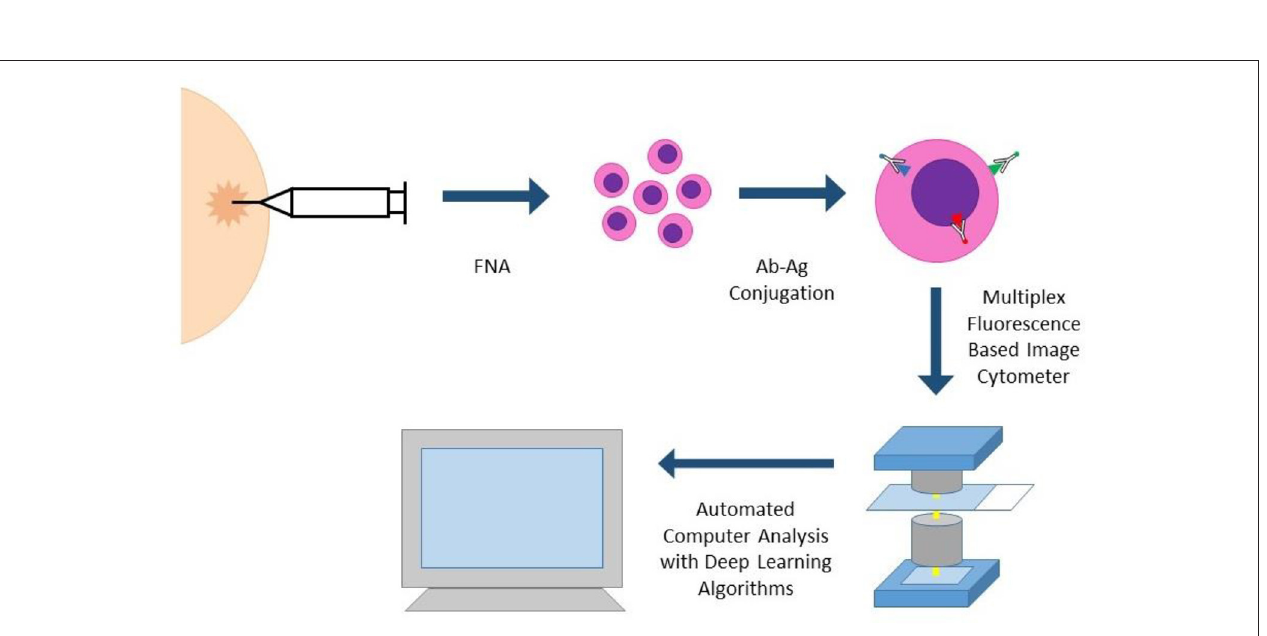
Frontiers in Medicine |